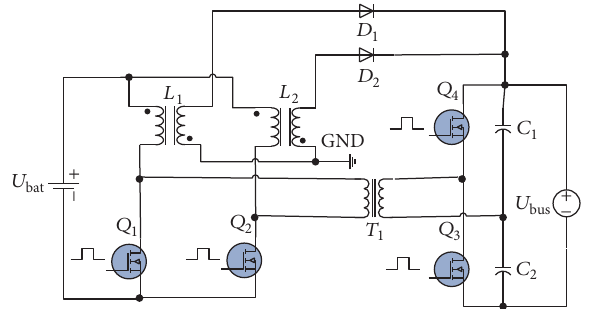
Figure 1: Circuit topology of bidirectional half-bridge current- doubler converter.